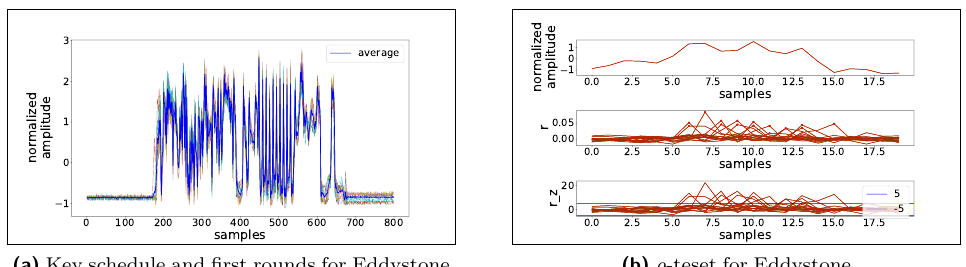
Figure 22: The key schedule and the first rounds of AES-128 are clearly visible in the traces we collect for Eddystone (a). The correlation peaks for p ⊕ k are clearly present as well (b).